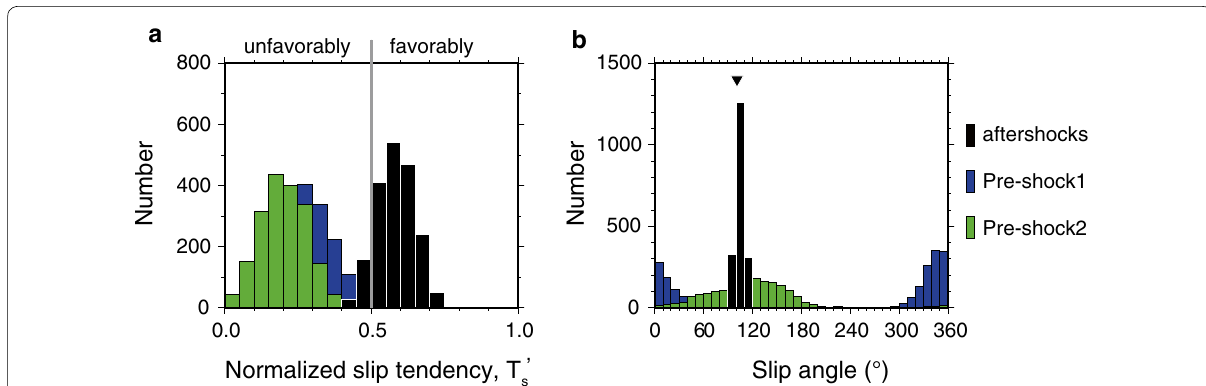
Fig. 9 Driving stress of the Awaji Island earthquake. a Slip tendency analysis for the Awaji Island earthquake fault. The frequency of the normalized slip tendency ( T s ’) is computed from the 95% confidence region of the assumed stress tensors. The black, blue, and green colors show the results obtained assuming the stress tensors derived from aftershocks, Pre-shock1, and Pre-shock2, respectively. b Slip angle expected by the stress tensor derived from aftershocks, Pre-shock1, and Pre-shock2. The meaning of colors is the same as in a . The frequency is computed from the stress tensors included in the 95% confidence region. Inverted triangle shows the average rake angle of mainshock (Appendix B)